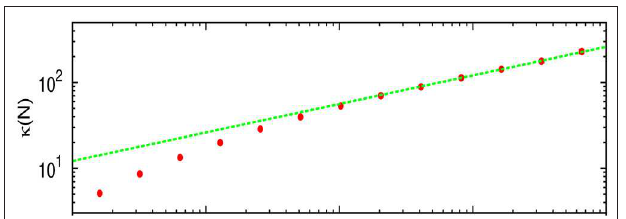
FIGURE 4 | FPUT- β model: Results for conductivity κ vs. N for T ℓ T r 0.5. The last five points fit to a slope of 0.333 = et al. with permission from [10] Copyright (2007) by American Physical Society).